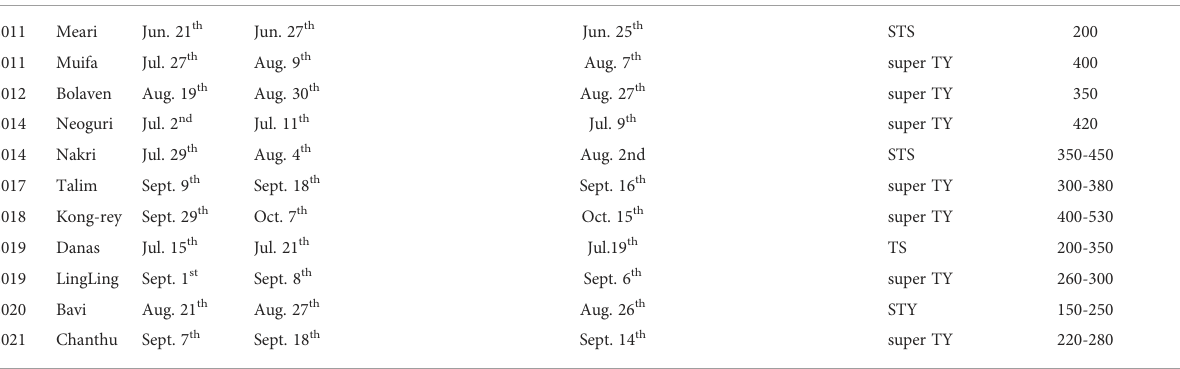
TABLE 1 Information on typhoons that affected the Yangtze Estuary from 2011 to 2020.